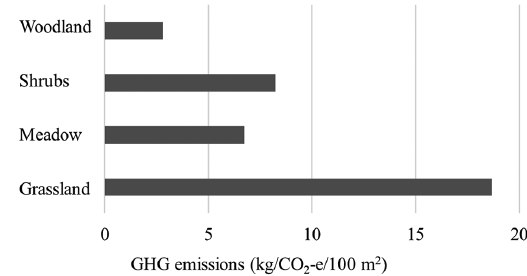
Figure 9. Average GHG emissions of the various plant layers in the cemetery green space